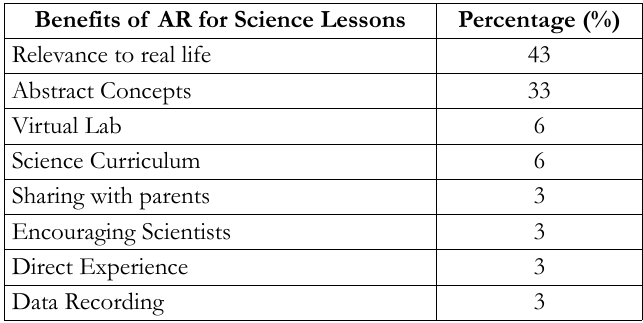
Table 13. Percentage of teacher responses to AR Benefits for Science